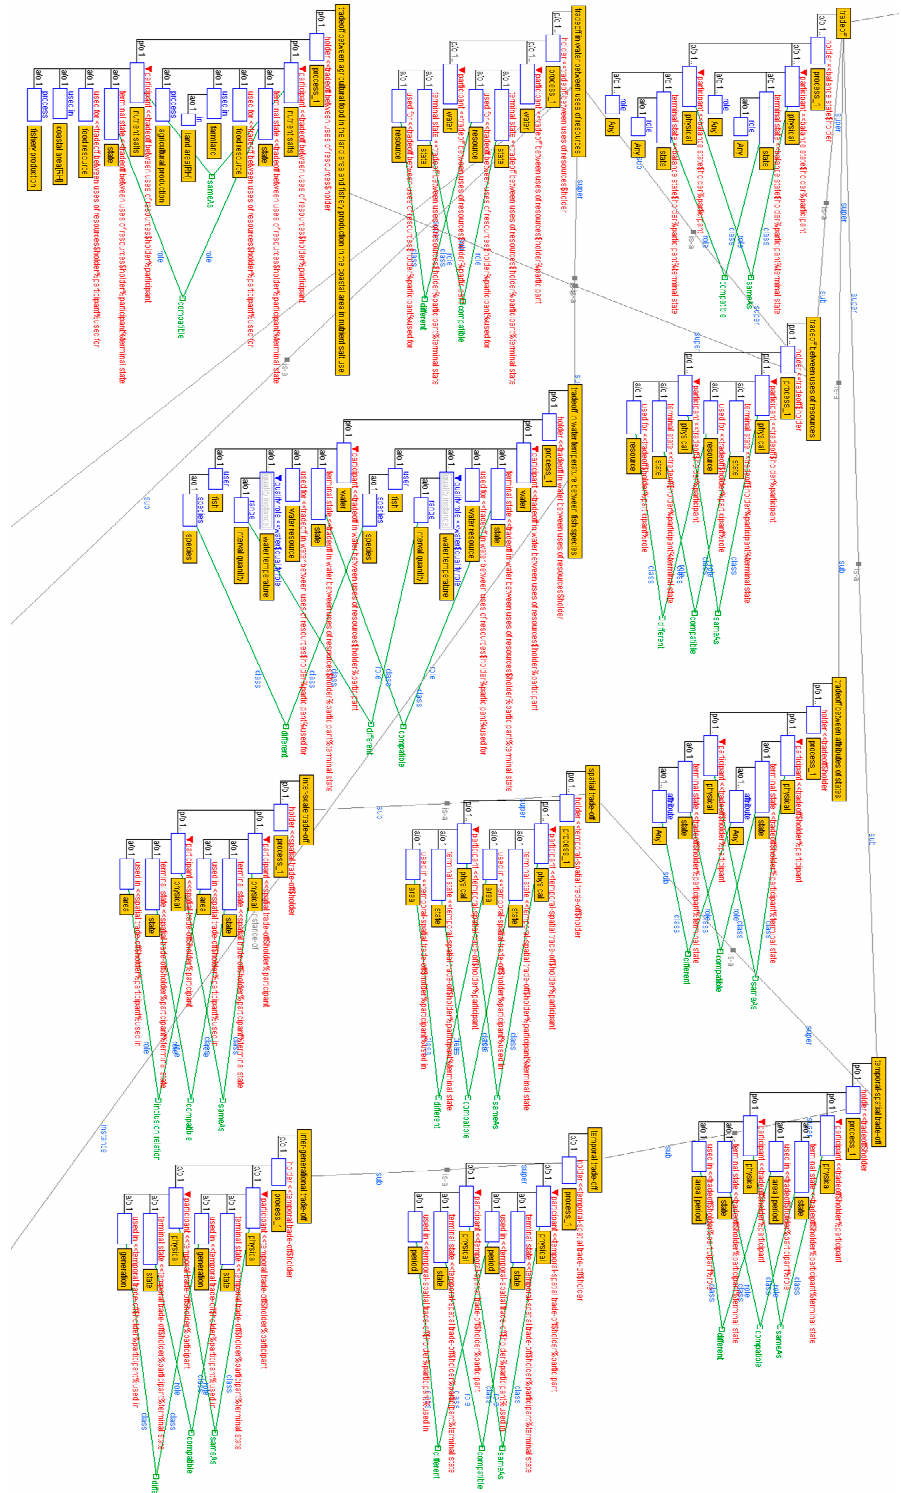
Figure 6. The structure of the sub ‐ concepts of trade ‐ off in the nexus domain ontology.